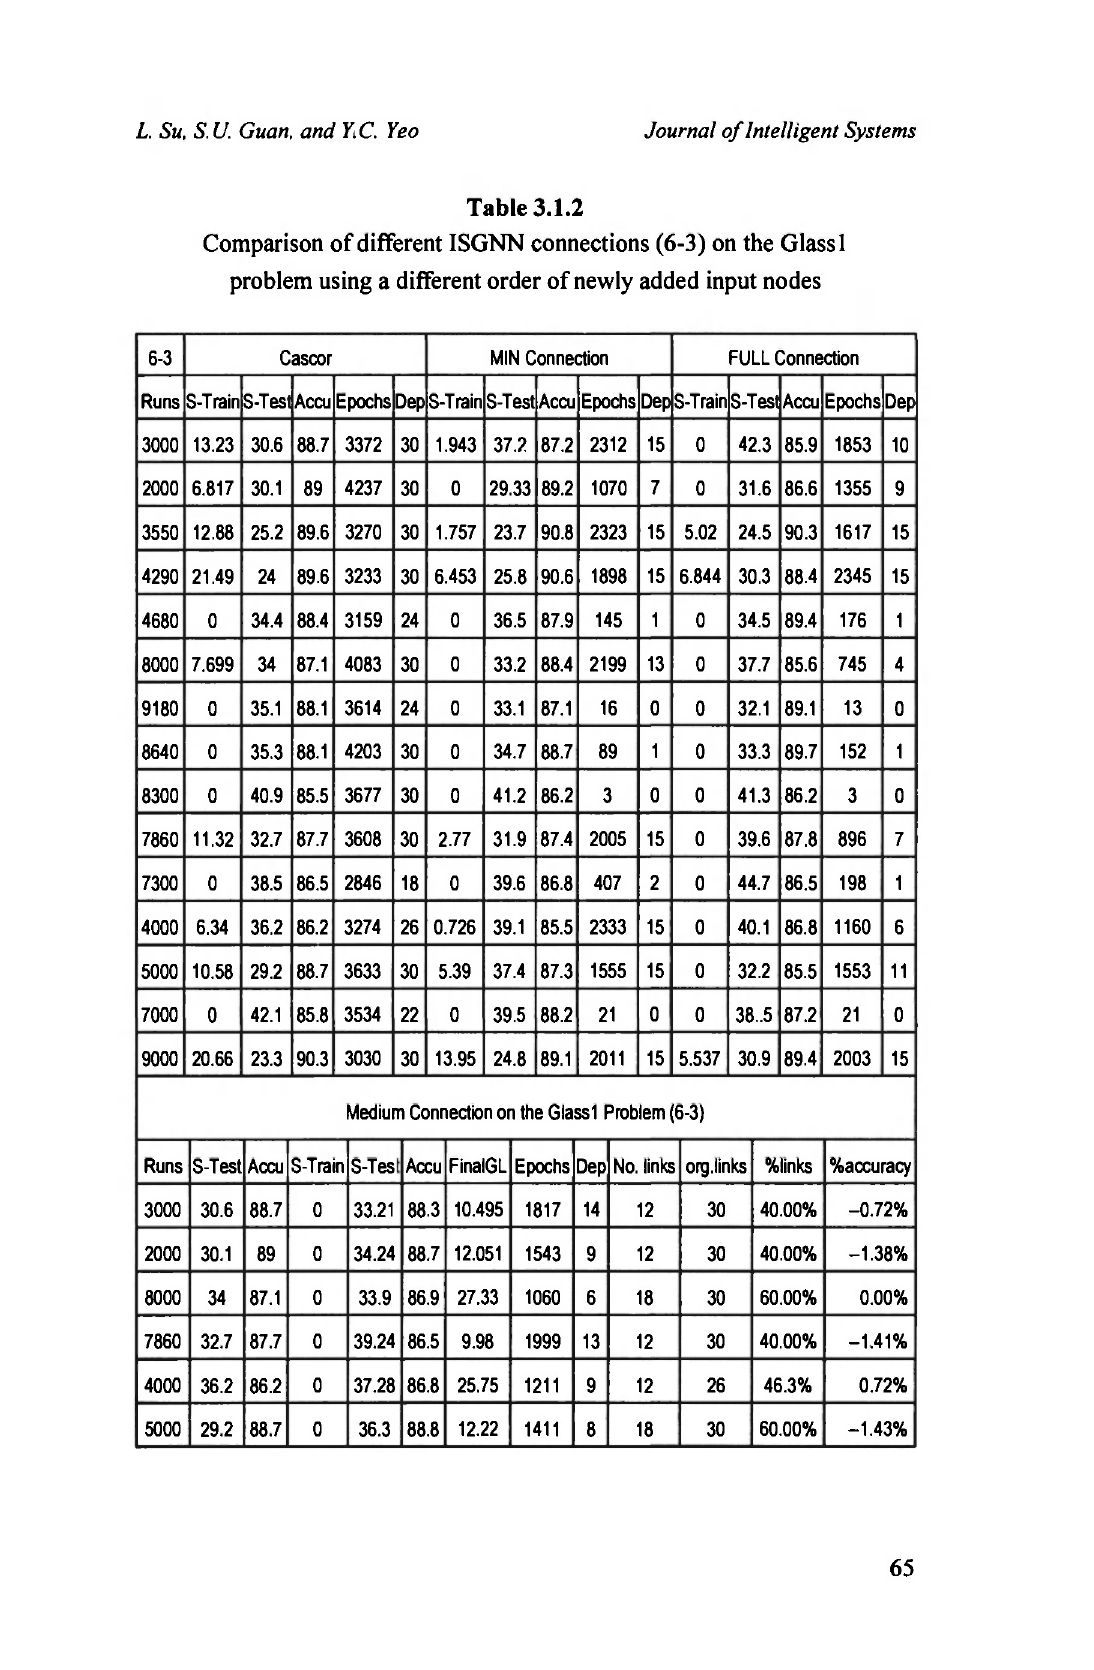
Comparison of different ISGNN connections (6-3) on the Glass 1 problem using a different order of newly added input